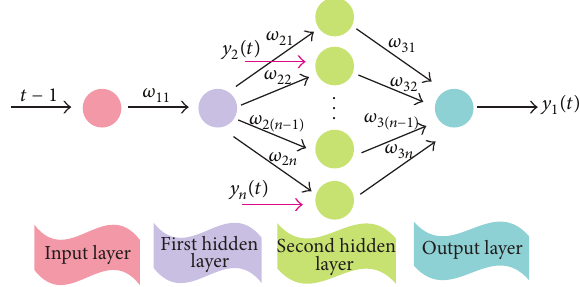
Figure 1: Structure of the GNN